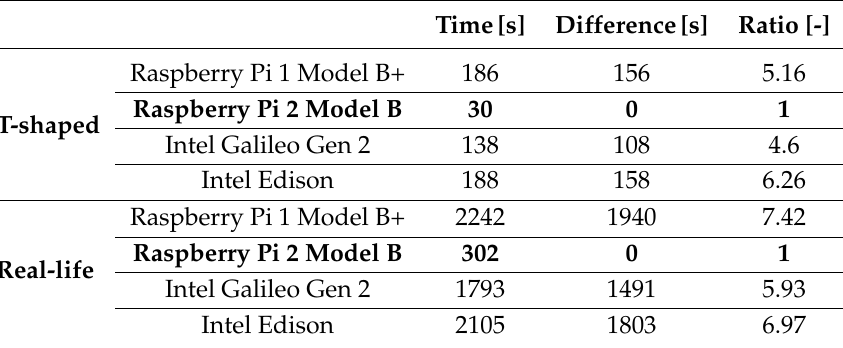
Table 4. Comparing results for both